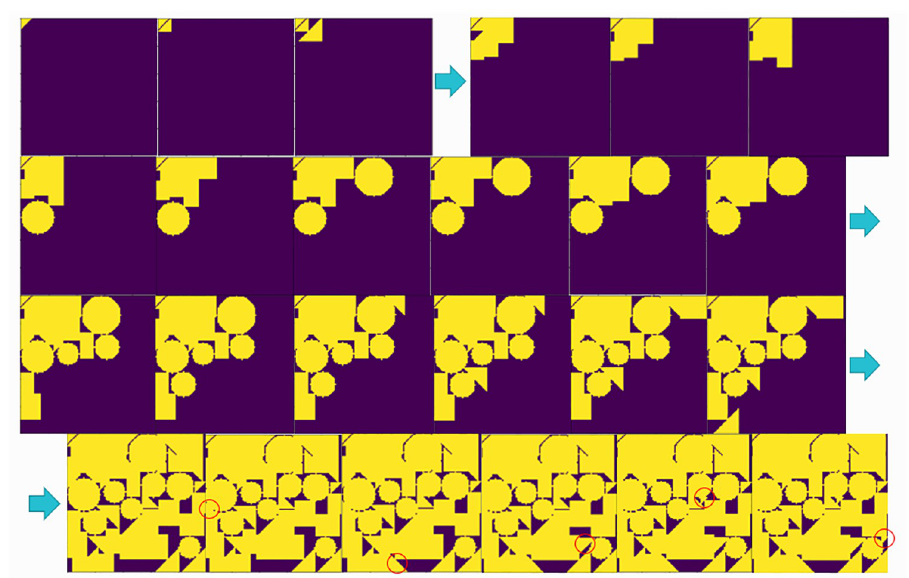
Fig 13. The whole layout process. The whole layout process for complete raw materials.